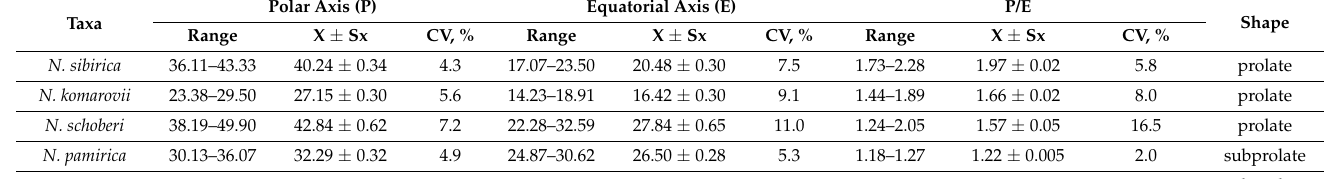
Table 3. Sizes ( µ m) and shape of pollen grains of Nitraria . The data are presented as the mean (X), standard error (Sx), and the coefficient of variation (CV, %).